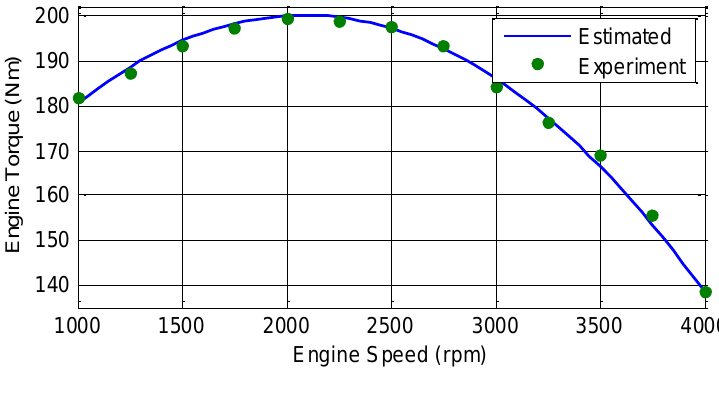
Figure 4. Fuel consumption rate of the